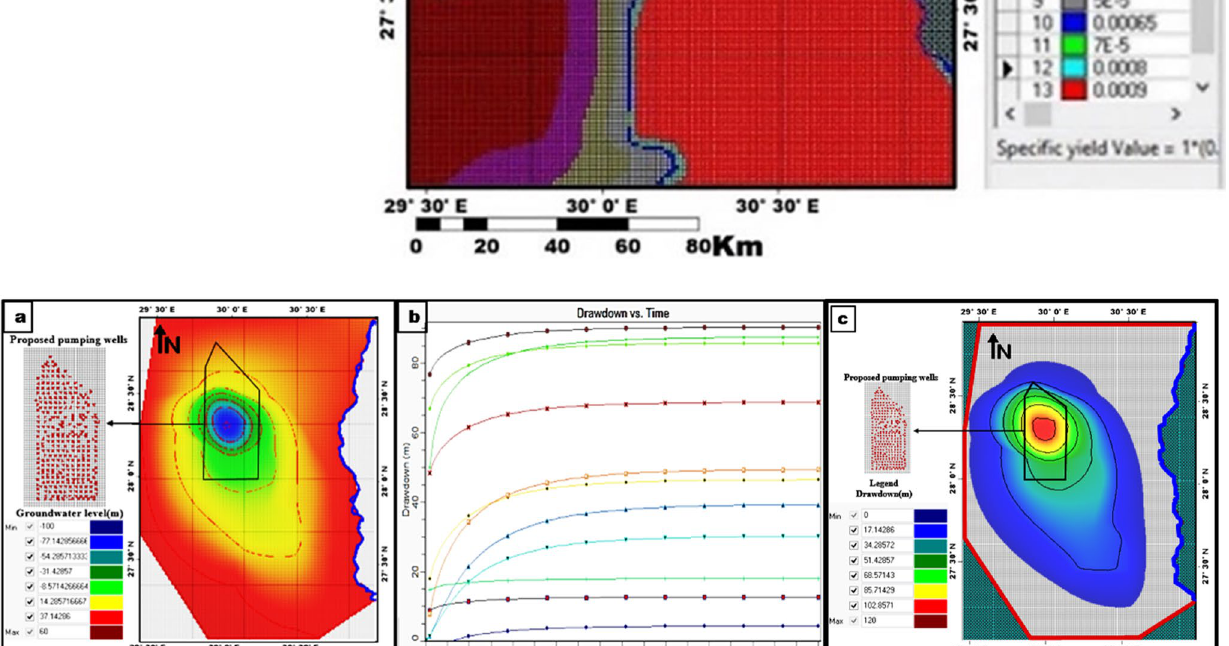
Fig. 16 Model results of the first simulated scenario: a hydraulic head distribution, b drawdown versus time and c drawdown